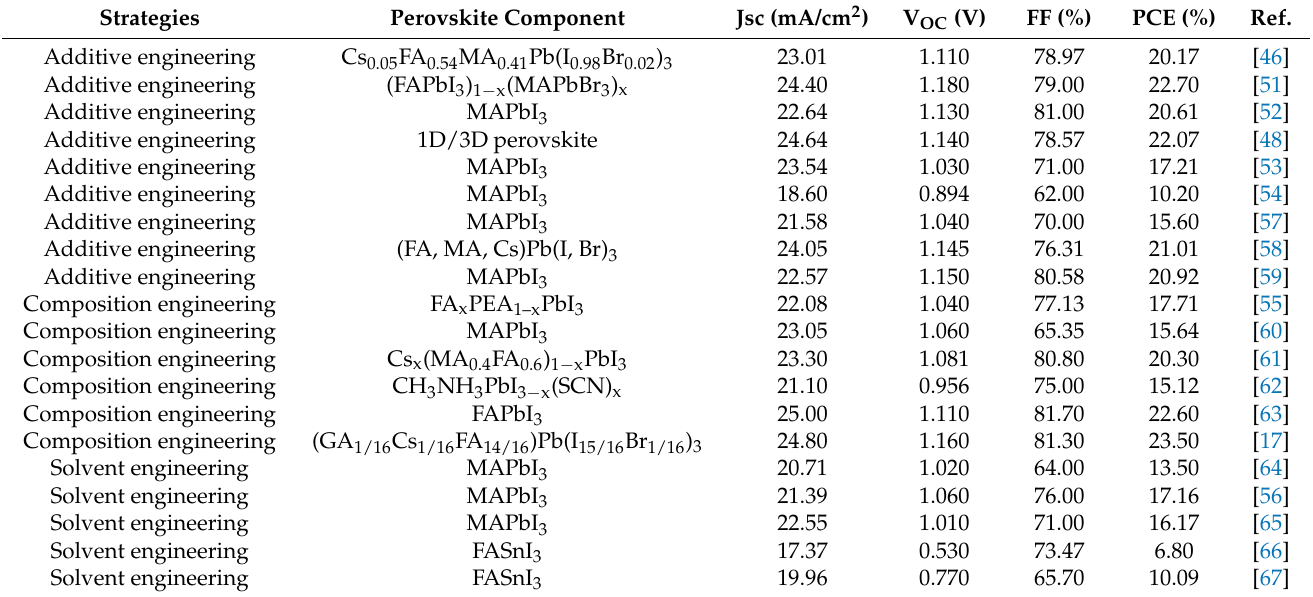
Table 1. Summary of some strategies for manipulating crystallization kinetics using a two-step